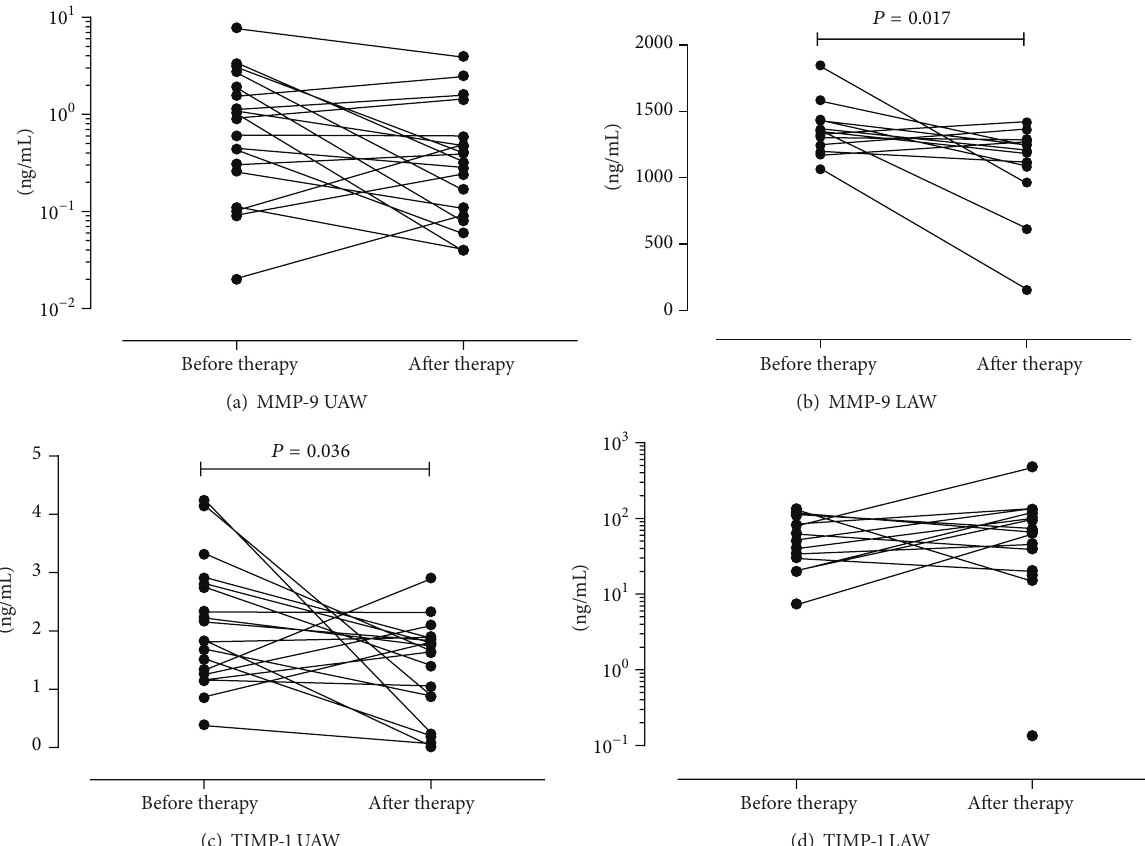
Figure 4: Changes of MMP-9 and its inhibitor TIMP-1. Levels of MMP-9 decreased in UAW (a) and LAW (b) after therapy; only changes in LAW reached statistical significance. Concentrations of TIMP-1 decreased significantly in the UAW (c) while levels increased in the LAW